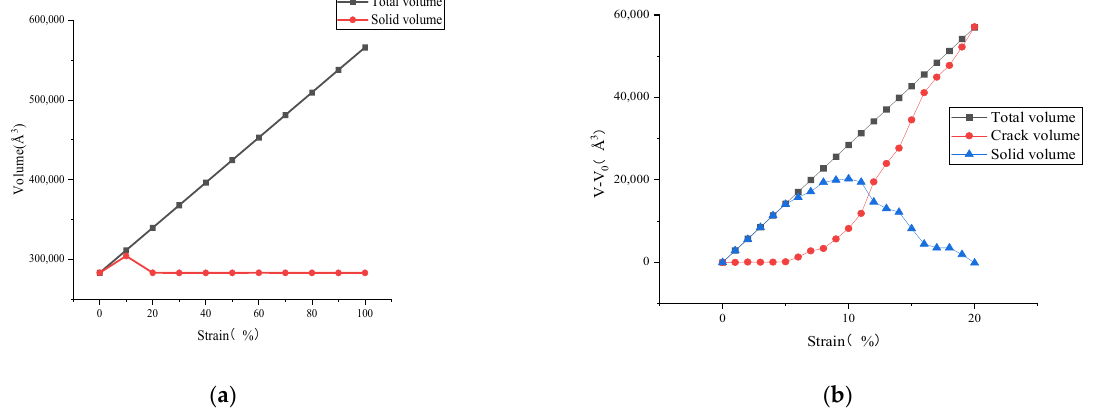
Figure 8. ( a ) Total volume versus asphalt volume change during stretching; ( b ) volume change of each part during 0–20% strain stage.